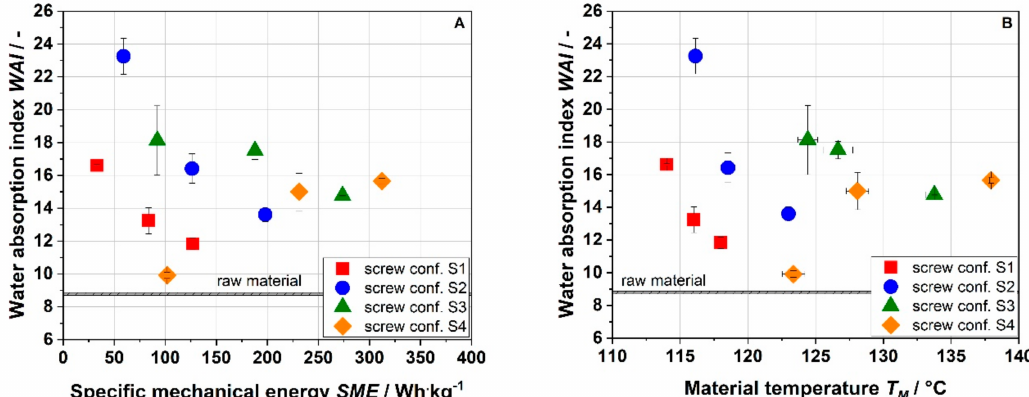
Figure 7. Effect of specific mechanical energy SME ( A ) and material temperature T M ( B ) on water absorption index (WAI) of apple pomace for various screw configurations at a water content of 22%. S1: only transport elements, S2: two reverse elements, S3: four reverse elements, S4: two reverse elements and a kneading block.